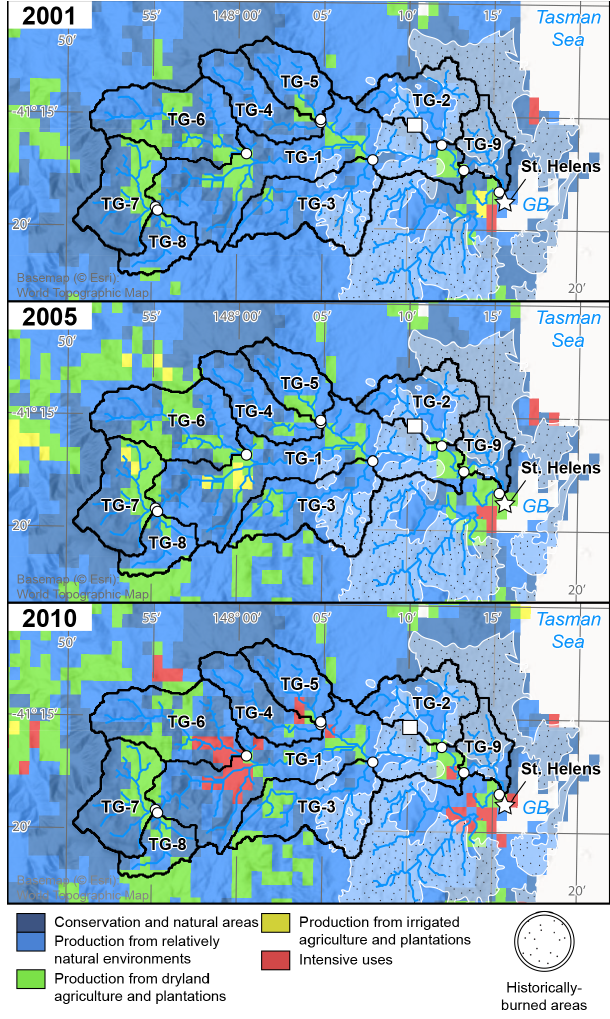
Figure 4. Land cover for each sampled tributary catchment in the George River basin from 2001 (top), 2005 (center), and 2010 (bottom) – the period of leading up to and immediately follow- ing sample collection in 2008. The Australian Land Use and Man- agement Classification system groups land use into five primary classes based on their potential to impact the natural environment (ABARES, 2016). The white square denotes location of the Gentle Annie experimental catchment (Wilson, 1999). Stippled areas out- lined in white are areas that have been affected by forest fires or prescribed burns in the past (Land Tasmania, 2020). Maps are pro- jected in UTM Zone 55S. Topographic relief base maps come from the ArcGIS Online World Topographic Map (Esri, 2012).